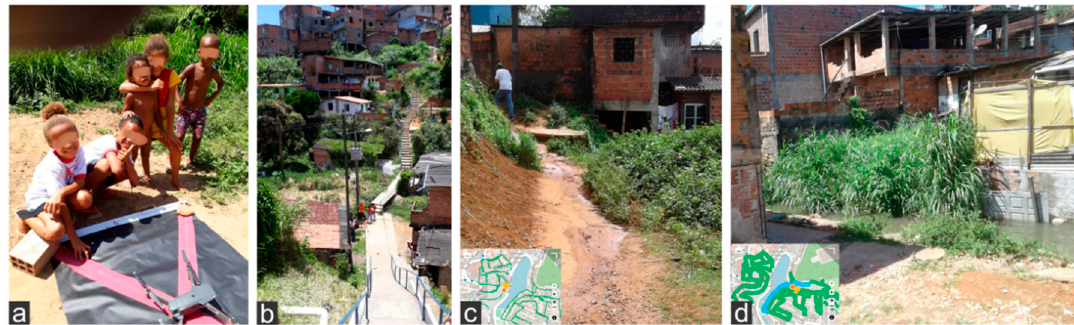
Figure 2. Scenes of Salvador’s slums, Brazil: ( a ) children either barefoot or with no clothes on playing in a lowland open area and watching the unmanned aerial vehicle (UAV) take-off; ( b ) narrow pathways and typical occupation of slopes; ( c , d ) open ground photo data archive Mapillary showing a humid unpaved pathway and house typology (Photos a and b by Patricia Brito).